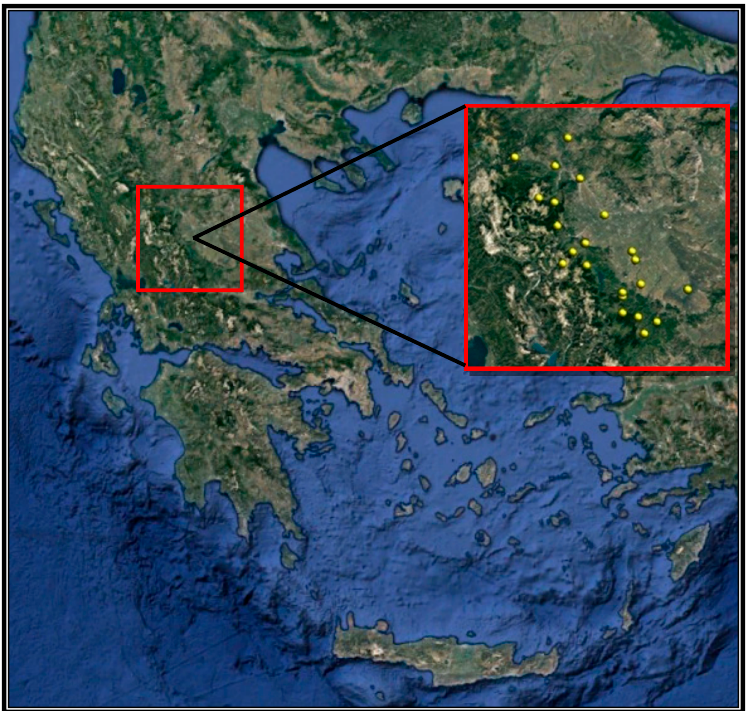
Figure 2. Central Thessaly meteorological